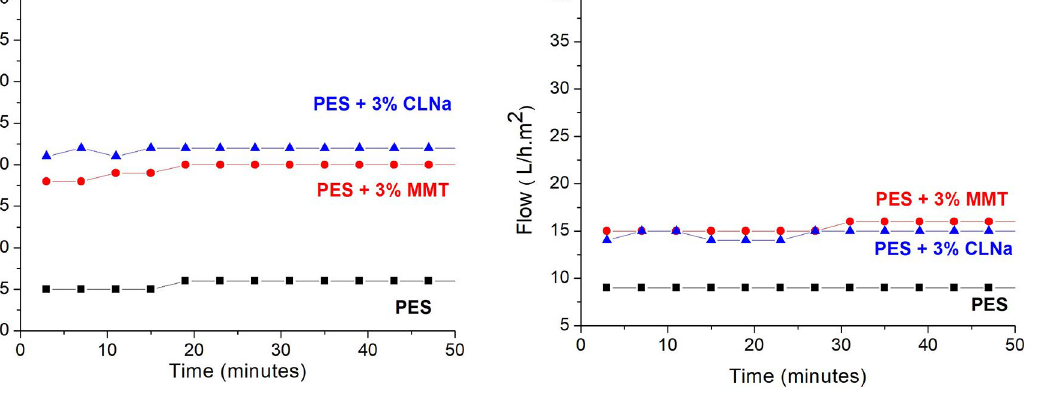
increasing the permeability of the membrane.